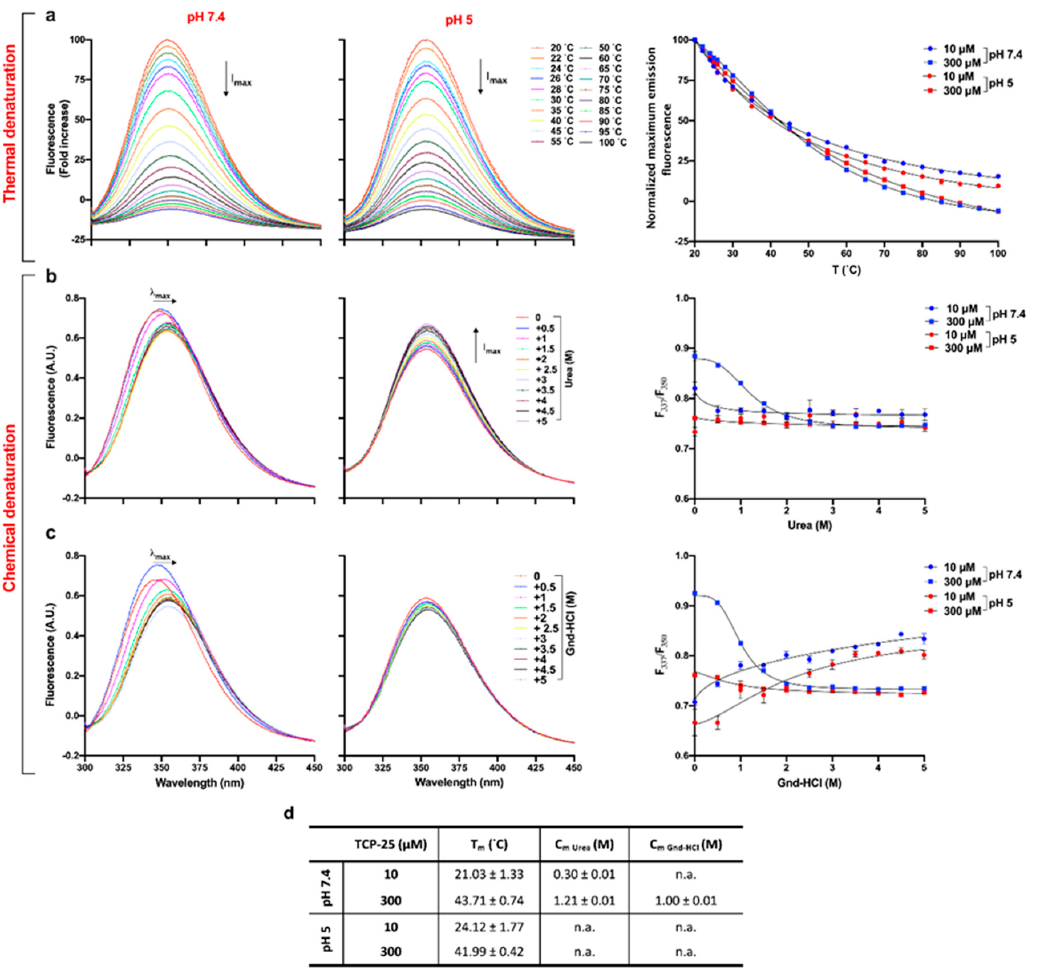
Figure 3. Thermal and chemical denaturation of TCP-25. TCP-25 (10 and 300 µM) in 10 mM Tris at pH 7.4 or in 10 mM NaOAc at pH 5.0 was denatured by increasing temperature ( a ) or by addition of increasing amounts of urea ( b ) or Gdn-HCl ( c ). The unfolding process was analyzed by recording the emission spectra between 300 and 450 nm upon excitation at 280 nm. Representative emission spectra are shown for 300 µM TCP-25 dissolved at pH 7.4 or 5.0 with different denaturing methods ( n = 3). On the right, the denaturation curves are reported. In the case of thermal denaturation, data were obtained by fitting the normalized maximum emission fluorescence as a function of the temperature. For the chemical denaturation, results were obtained using the fluorescence ratio (F 337 / F 350 ) as a function of the concentration of the chemical agent. Each data point represents the mean ± SEM ( n = 3). ( d ) Table showing T m and C m ± SEM calculated from the denaturation curves obtained from 3 independent experiments done in duplicate ( n = 3). → indicates shift in the maximum fluorescence intensity ( λ max ); ↑ I ↓ I max and max indicate increase and decrease in maximum fluorescence intensity,